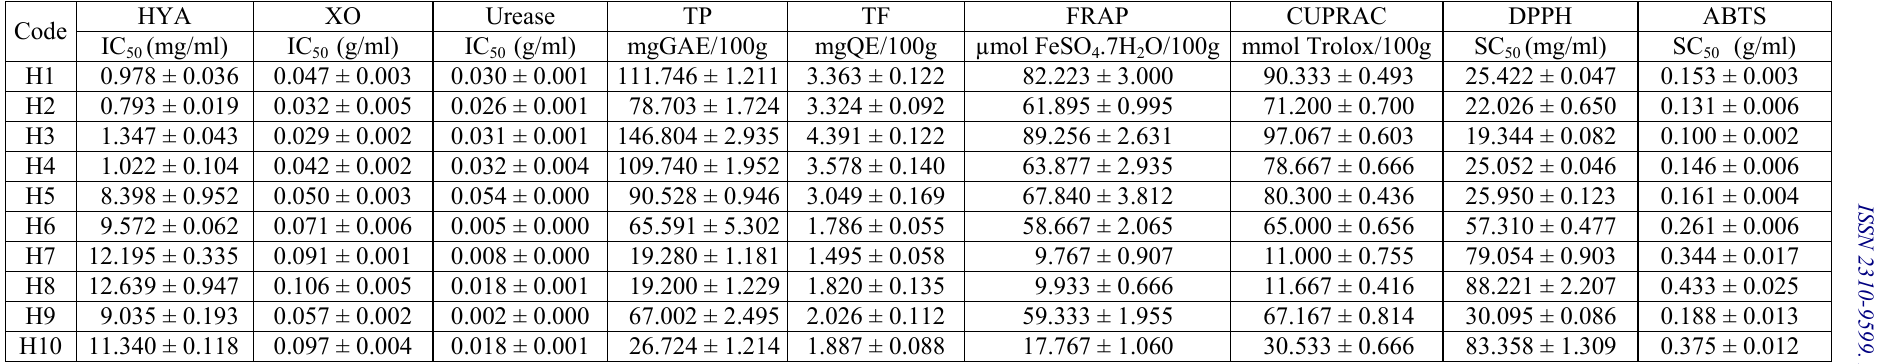
Table 2. IC 50 values of each enzyme and antioxidant properties of honey samples* Code